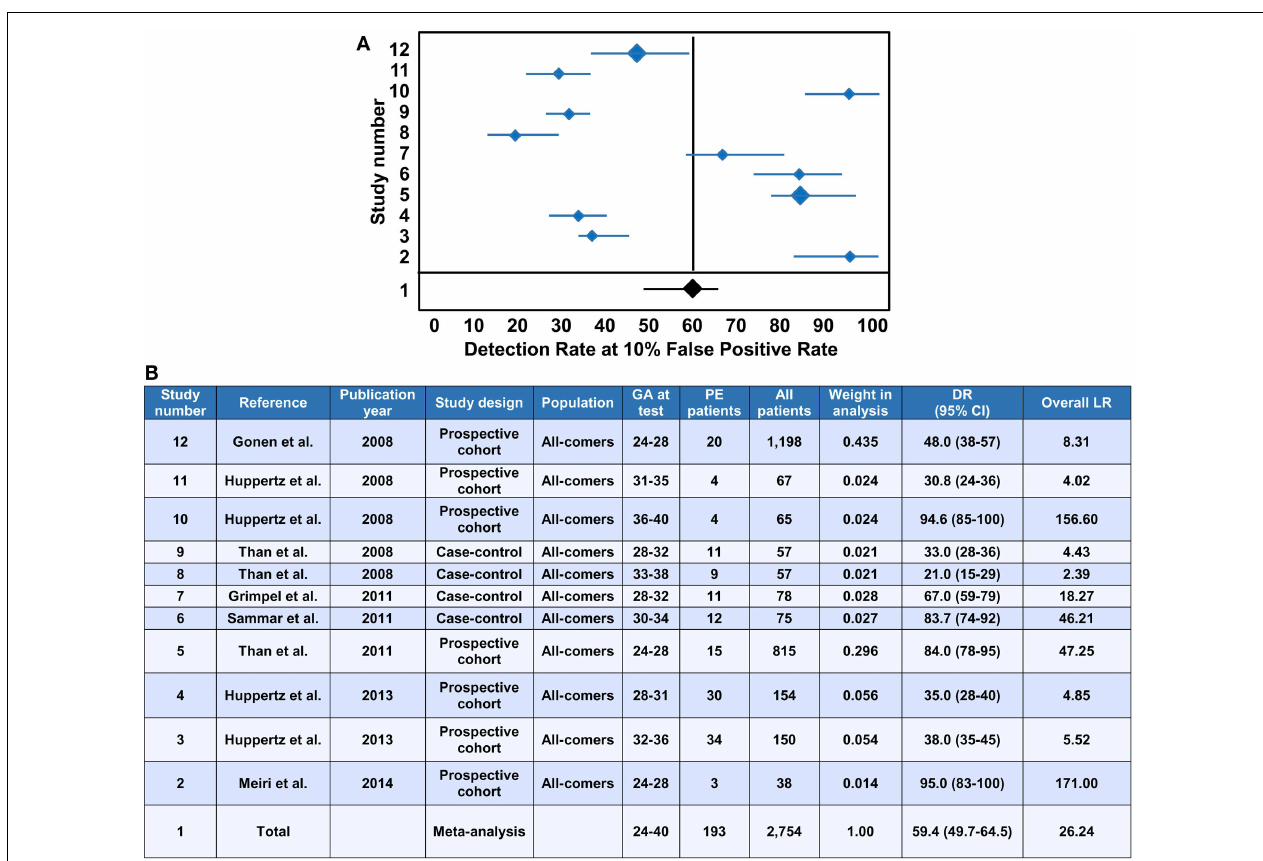
diamonds.The relative weight of a certain study in the analysis is reflected by the relative size of the diamonds. (B) The table lists all studies used to perform the Forest plot for the meta-analysis.Weight represents the relative impact of the study in the meta-analysis. DR for 10% FPR is shown along with the 95% confidence interval (95% CI).The Likelihood ratio (LR) was calculated for positive LR [sensitivity/(1-specificity)], negative LR [(1-sensitivity)/specificity] and overall LR (positive LR/negative LR). For the meta-analysis, the values were adjusted to the relative weight of each study in the meta-analysis.The numbers on the left side of the table correspond to the graph numbers in (A) . PE, preeclampsia; GA, gestational age in